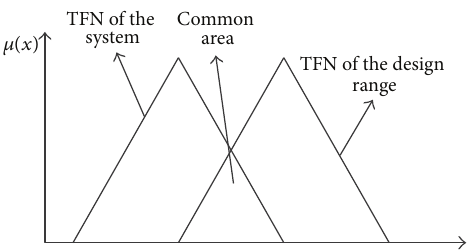
Figure 5: Common area of system and design range